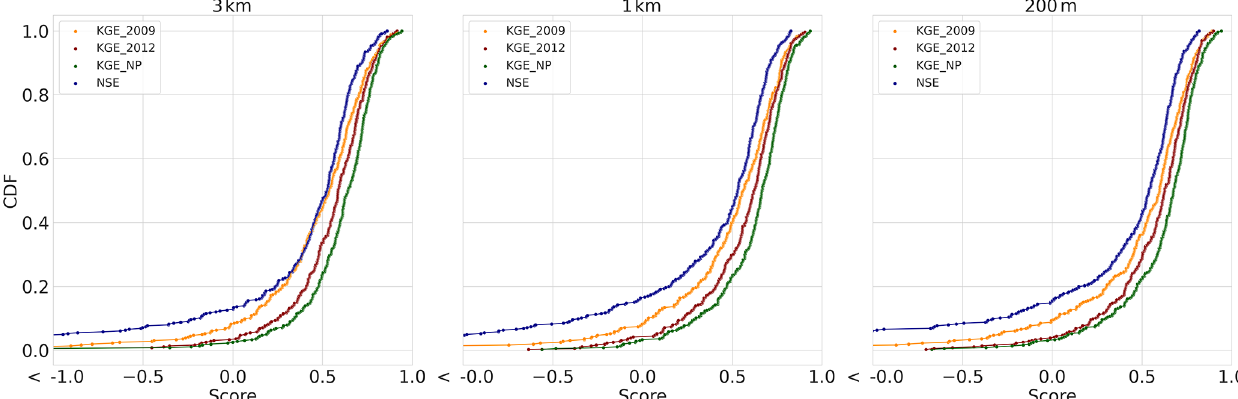
Figure A2. Evaluation period results. CDFs of multiple objective functions for the three model instances with KGE 2009 in orange, KGE 2012 in red, KGE NP in green, and NSE in